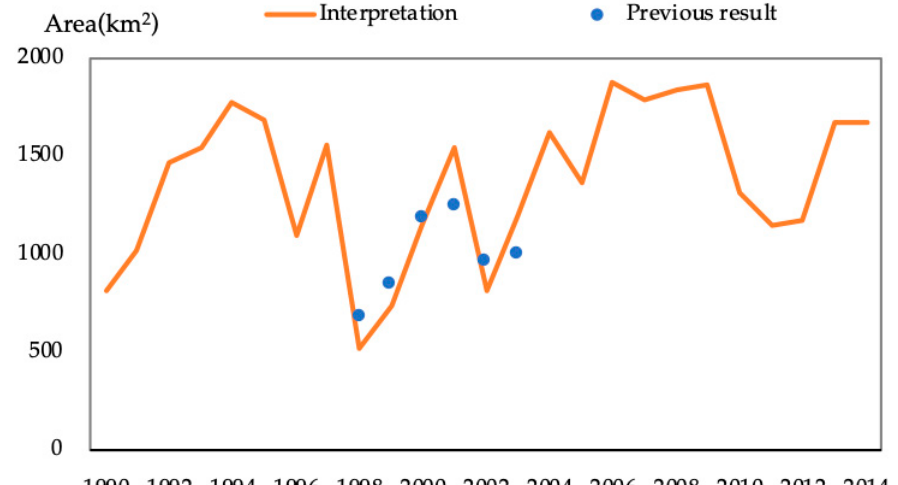
Figure 7. Comparison between the phragmite area in the remote sensing interpretation and the previous results from 1990 to 2014.